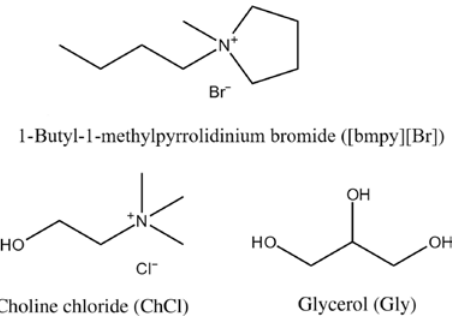
Figure 1: Chemical structures of [bmpy][Br], choline chloride and